Question: Write a single sentence explaining what this figure depicts.
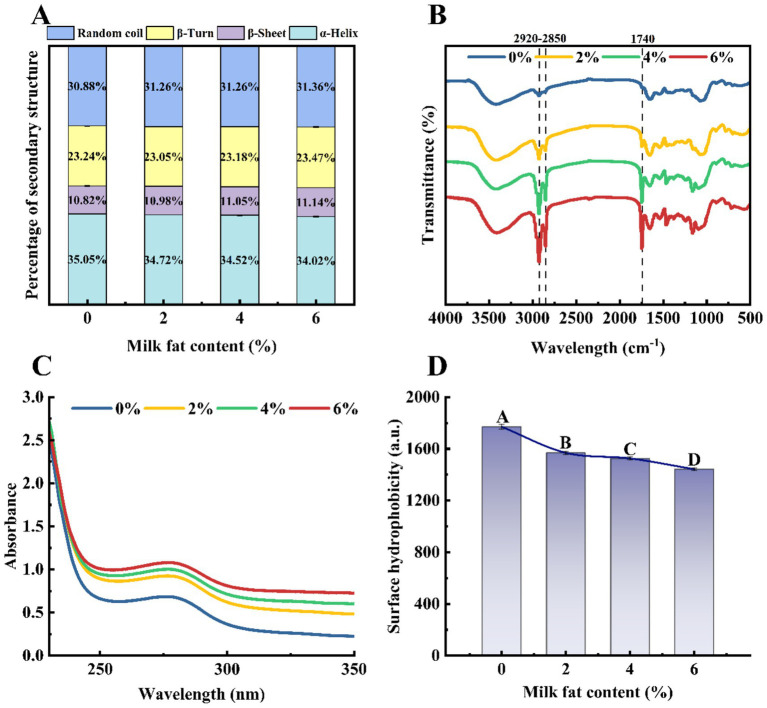
Answer: CD spectrum (A) ; FT-IR spectrum (B) ; UV–Vis absorption spectrum (C) ; and Surface hydrophobicity (D) of 4 groups milk with different milk fat contents (0, 2, 4 and 6%) ( n = 3).